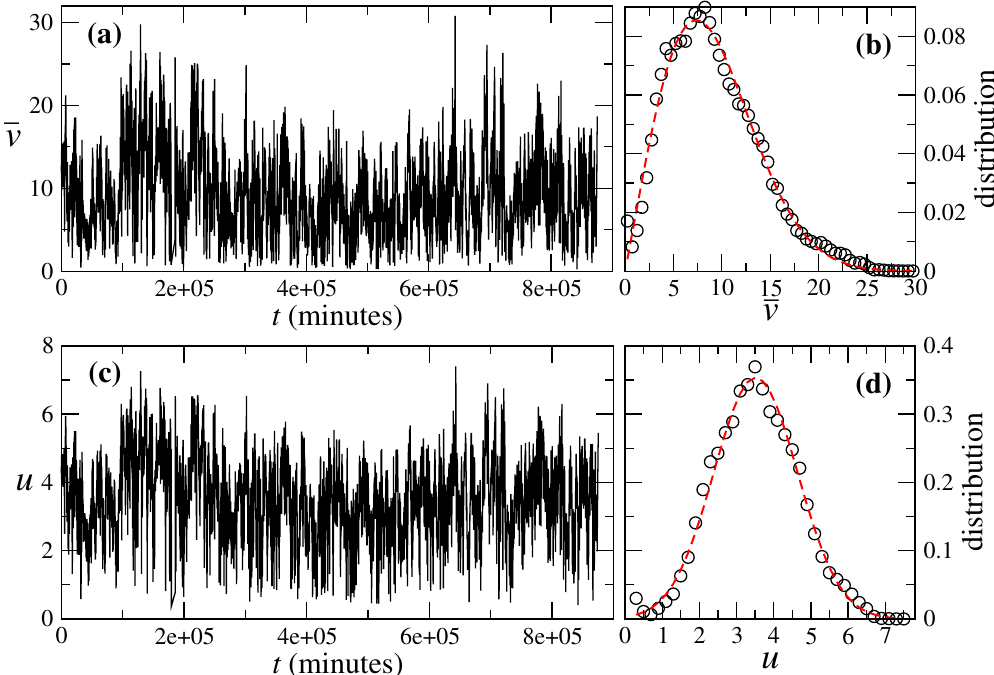
Figure 3. ( a ) series of the 15 min backward averages ¯ v and ( b ) their distribution (marked with symbols), which is well fitted by a Weibull form (solid line) with scale parameter λ = 10.17 m/s and shape parameter k = 2.07, corresponding to a mean µ ¯ v = 9.16 m/s and standard deviation σ ¯ v = 4.76 m/s. ( c ) Series of the transformed variable u ( t ) = [ ¯ v ( t )] α opt with α opt = 0.586, and ( d ) its distribution, which is well fitted by a Gaussian with mean µ u = 3.53 (m/s) α opt and standard deviation σ u = 1.14 (m/s) α opt